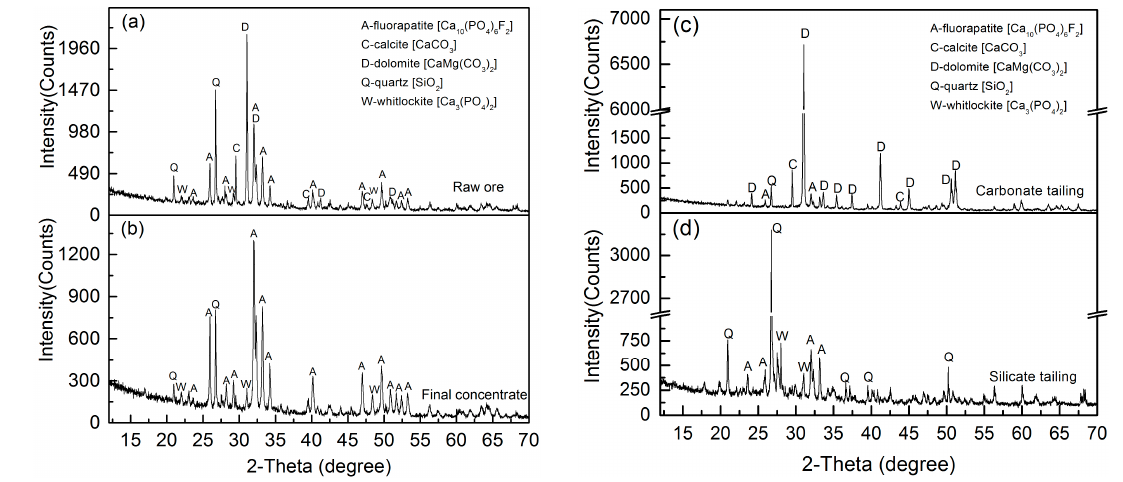
Figure 9. XRD patterns of raw ore and flotation products ( a ) raw ore; ( b ) final concentrate; ( c ) carbonate tailing; ( d ) silicate tailing.